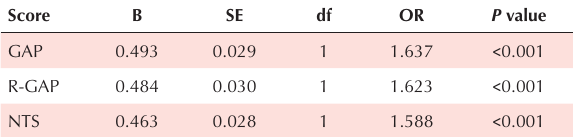
Table 5. The results of logistic regression analysis of GAP, R-GAP, and NTS trauma scores in outcome of